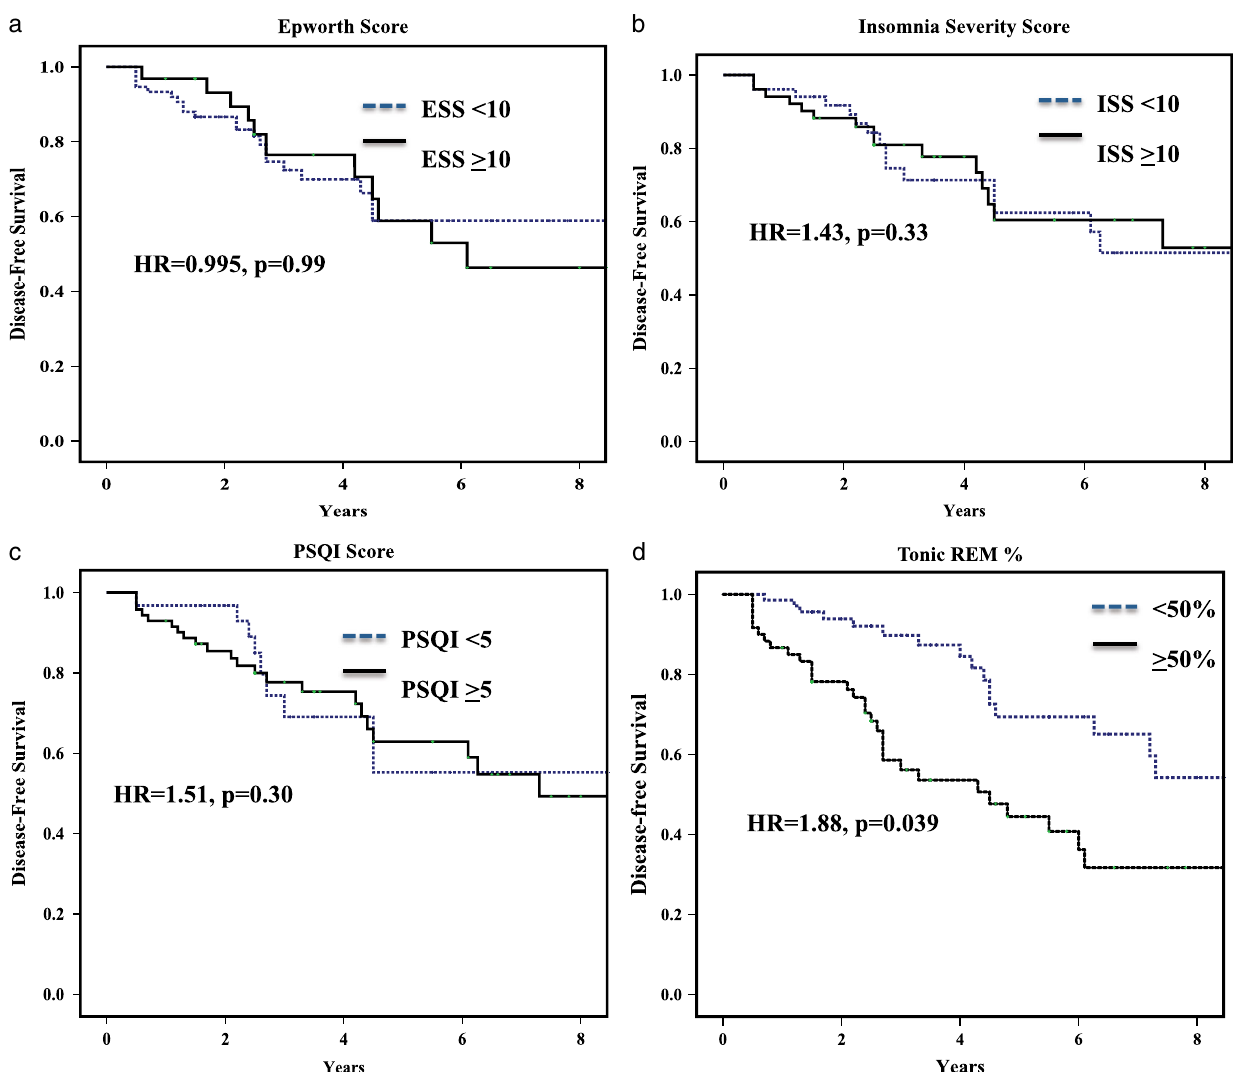
Fig. 1 Shown is the Kaplan – Meier plot of disease-free survival of patients with idiopathic RBD, strati fi ed according to the presence of sleep abnormalities: a Sleepiness, as assessed with the ESS, b insomnia as assessed with the Insomnia Sleep Index, c general sleep disturbance, as assessed with the PSQI, and d tonic REM, strati fi ed to greater or less than 50% of epochs. The HR is for Cox regression analysis, adjusted for age and